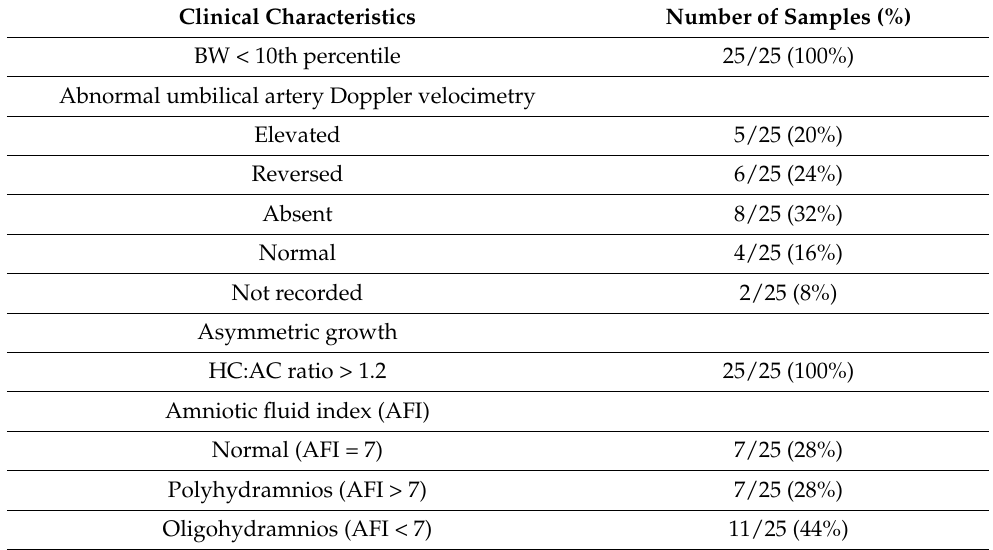
Table 2. Clinical criteria of FGR samples in this study.